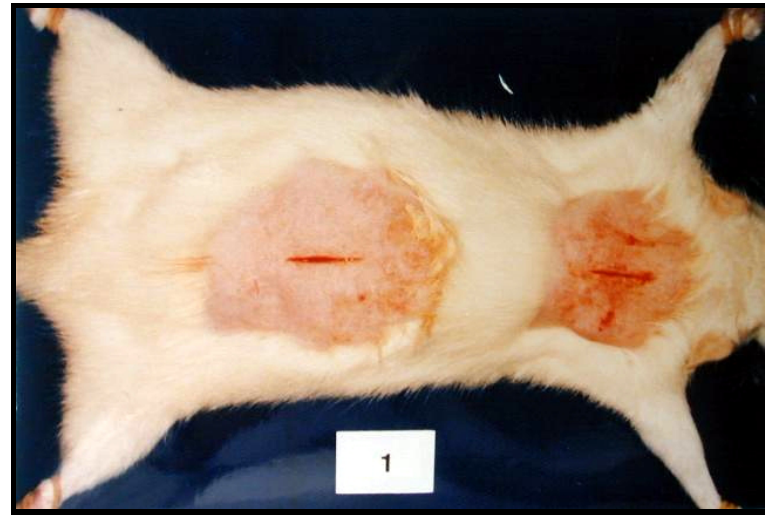
FIGURE 2- Photograph of rat, showing the two